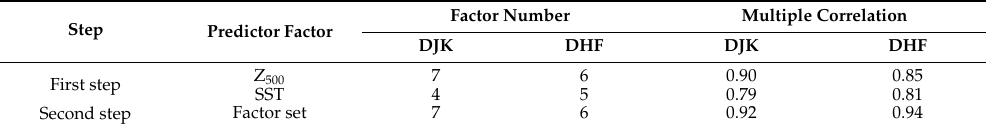
Table 3. Number of predictor factors in the first- and two-step stepwise regression and the multiple correlations for the Dahuofang (DHF) and Danjiangkou (DJK) Reservoir.